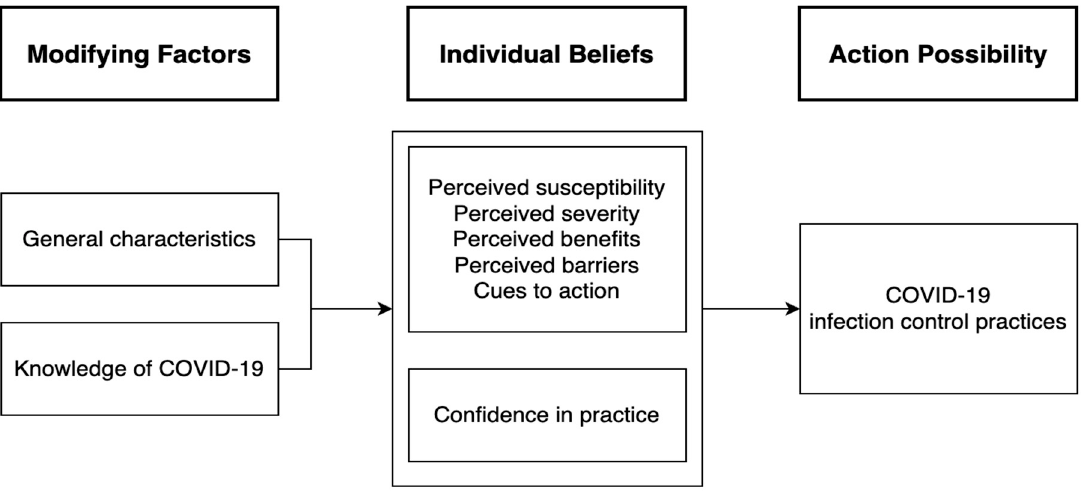
Figure 1. Conceptual framework of this study.